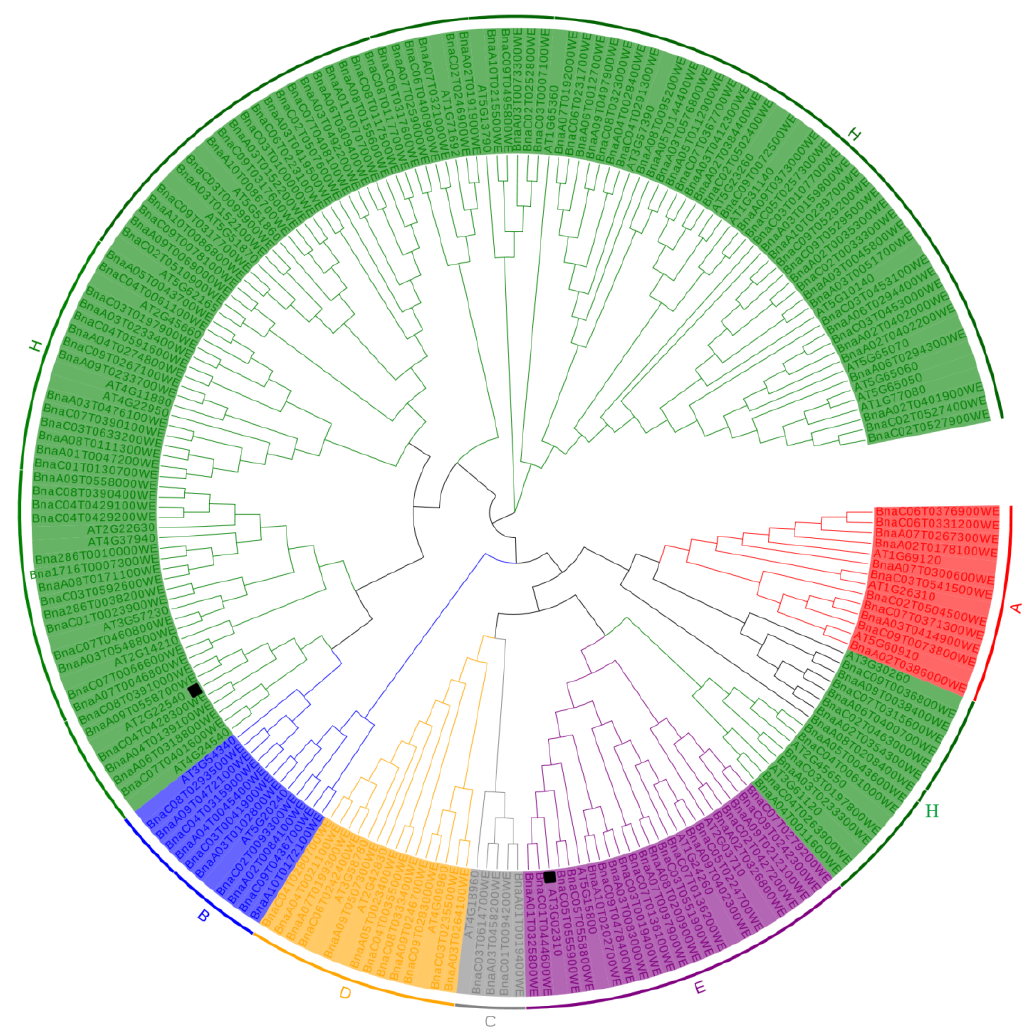
Figure 1. Phylogeny of the MIKC proteins from B . napus and A. thaliana . HMMER and BLASTP were used to identify MIKC genes [24].